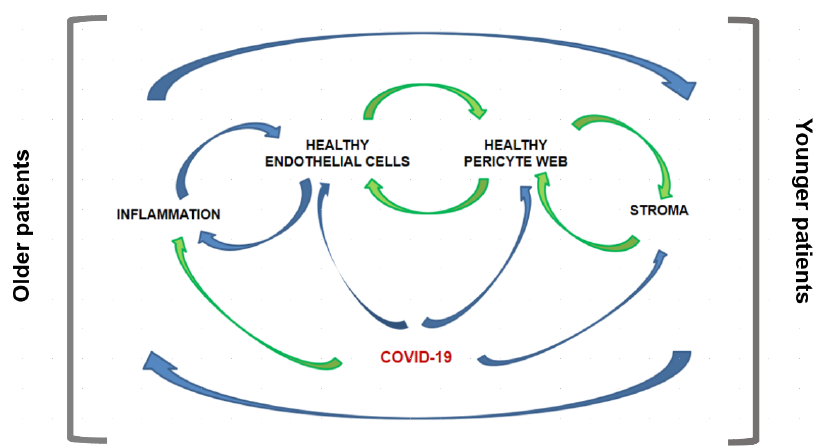
Figure 2. The casual loop proposition of hypothesis presented. Blue line for negative feedback and green line for positive feedback. Root-causes of altered pericyte networks may vary under the influence of different sets of genetic or epigenetic factors, and along the arrow of